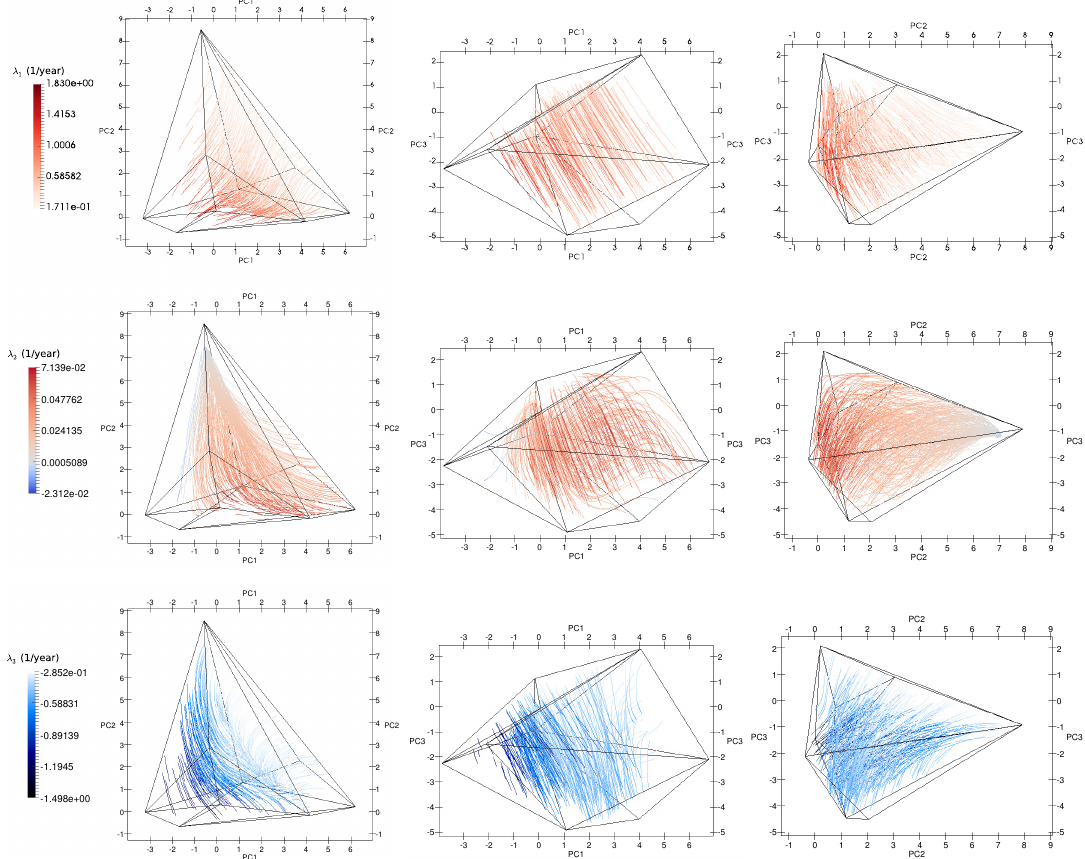
Figure 5. The trajectory patterns of the principal strain-rates at the year 2003: first principal strain-rate ( top ); second principal strain-rate ( middle ); and third principal strain-rate ( bottom ). The color scale in these graphs determines the strain type: the red color is used to represent extension, while the blue color depicts